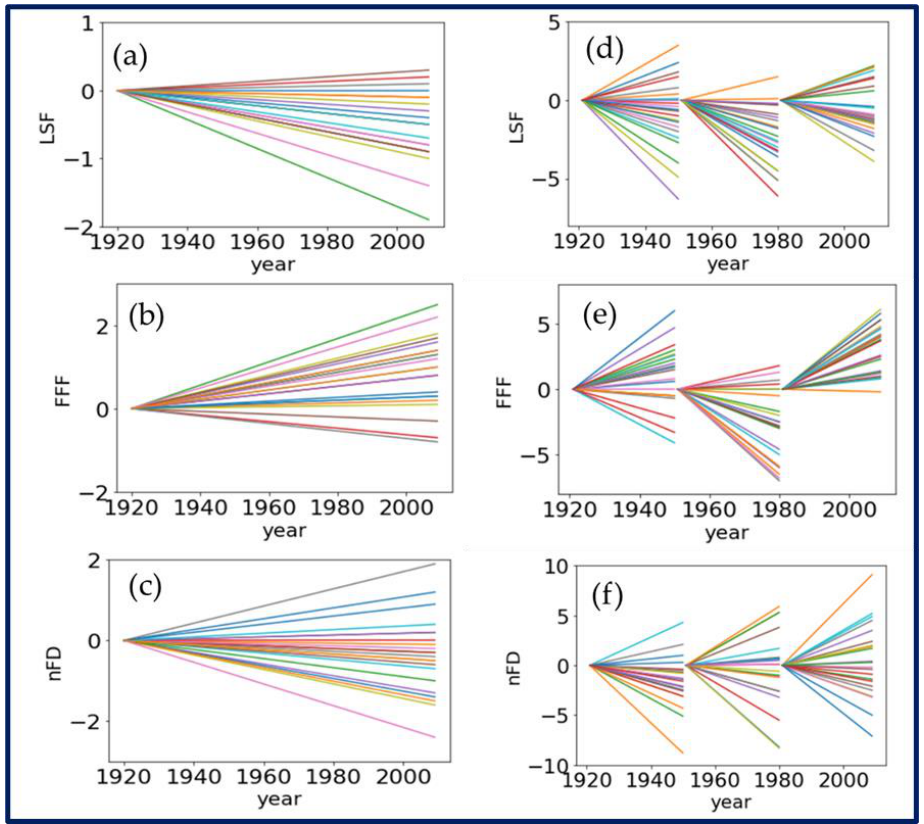
Figure 9. Long term linear trends (left panel, ( a – c )) on the day of the last spring freeze (LSF), number of frost days (nFD) and first fall freeze (FFF) and short term trends (right panel, ( d – f )) for the Kansas stations shown in Figure 1c. The multicolored lines are the trends.